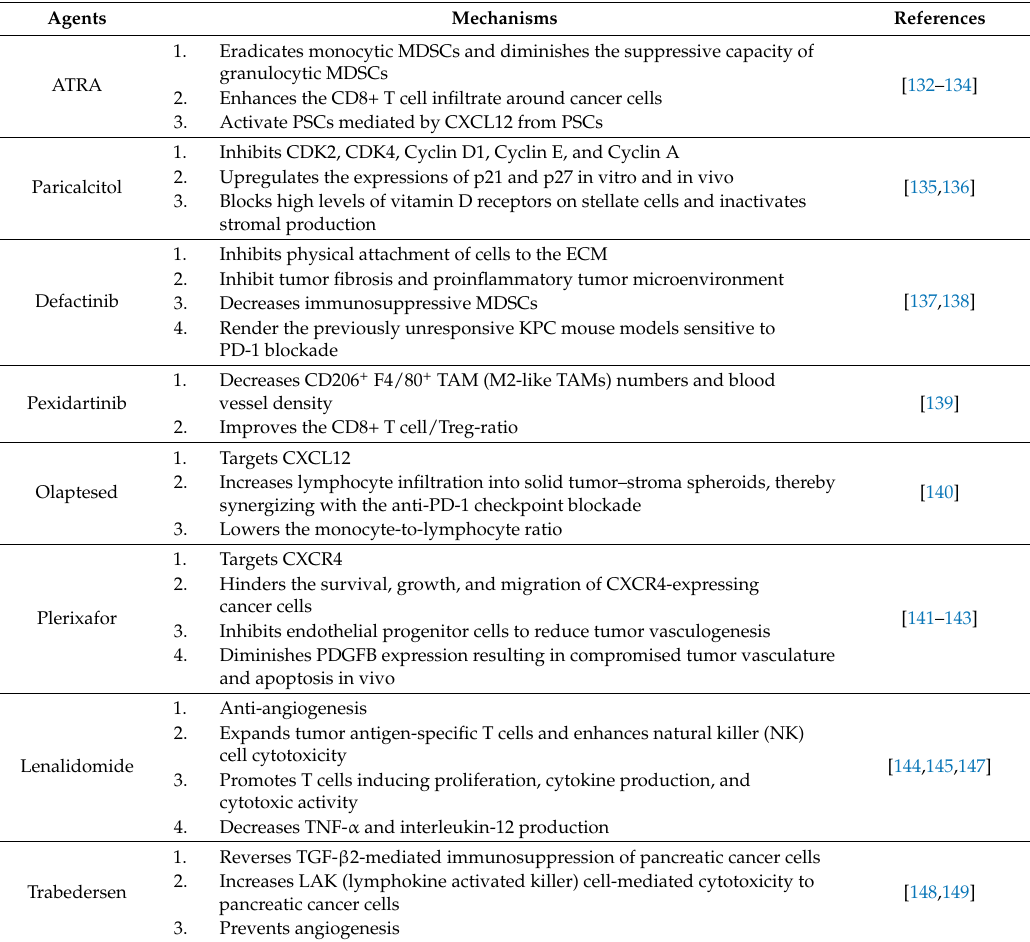
Table 3. Summary of mechanisms in targeting the tumor microenvironment